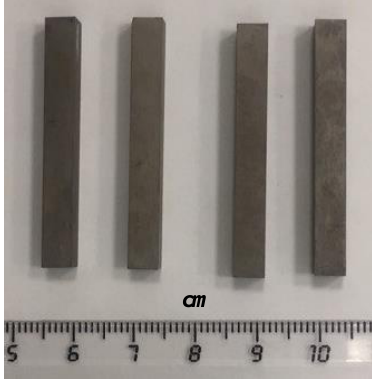
Figure 7. Pulsed electrospark deposition (PED) electrodes obtained using force self-propagating high-temperature synthesis (SHS)-pressing technology in a Ti –С– Co – Ca 3 (PO 4 ) 2 – Ag – Mg system.